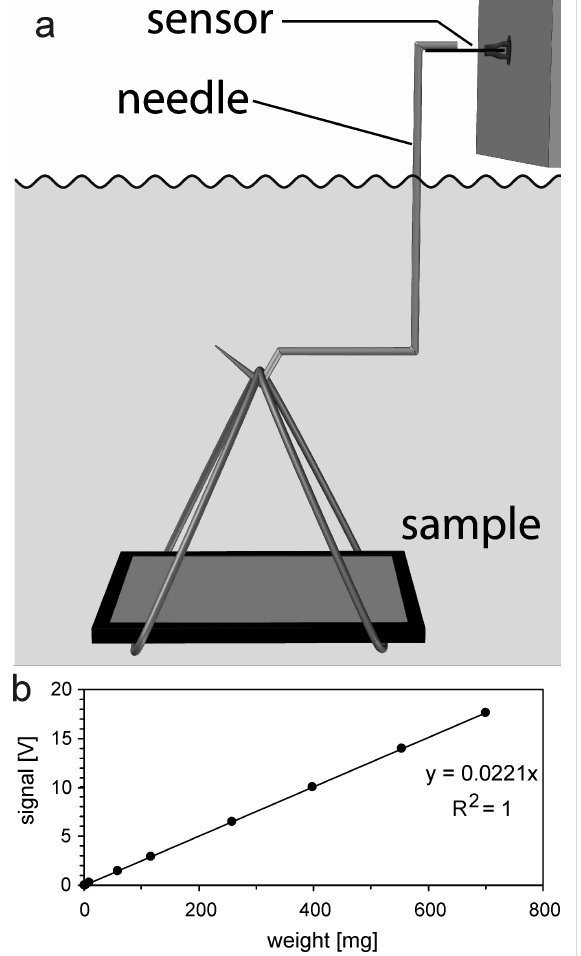
Figure 5: Buoyancy measurement setup. a) Schematic drawing of the measurement setup. A bent metal needle is glued to a silicon strain gauge sensor and submerged under water. Specimens with air layer were hung onto the needle by nylon strings. b) Calibration curve of the force transducer using nine weights in the range between 1 and 700